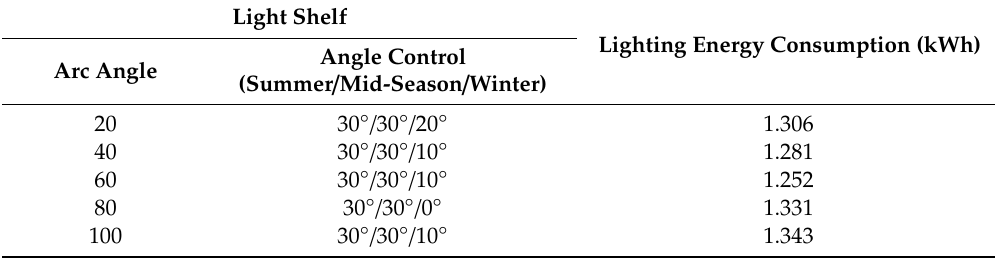
Table 11. Lighting energy consumption versus arc angle and angle control.